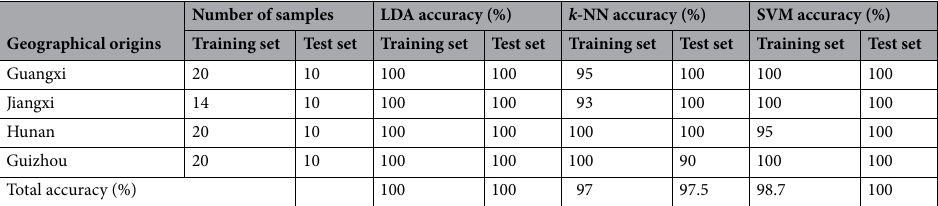
Table 2. The discrimination results of different models for the train set and the test set.